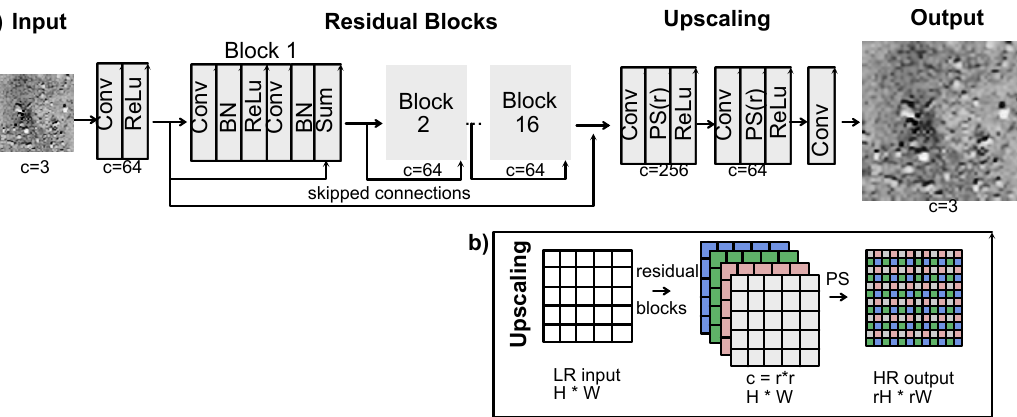
Figure 2. ( a ) Simplified structure of the used model based on [27,28]. ( b ) A schematic sketch of the upscaling procedure by pixel shuffling with an upscaling factor of 2 for a single-channel image is given in the lower right. The following abbreviations are used in a and b : c the number of channels of the input and output images and the intermediate feature maps; Conv convolutional layer; BN batch normalization layer; R eLu rectified linear activation unit; Sum Layer that elementwise sums the output of a residual block with the output of the prior residual block; PS(r) Upscaling by periodic pixel shuffling with the upscaling factor r ; H image height; W image